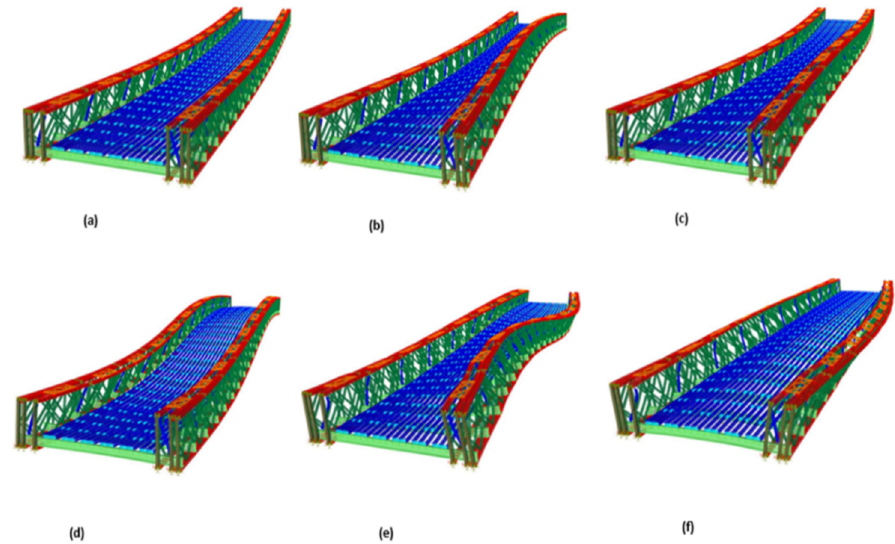
Figure 25. The first 6 eigenmodes of the FE model of the bridge ( a ) 1st: vertical bending at 2.87 Hz ( b ) 2nd: torsional-lateral at 3.22 Hz ( c ) 3rd: lateral-torsional at 4.38 Hz ( d ) 4th: second lateral at 7.50 Hz ( e ) 5th: second vertical bending at 8.73 Hz ( f ) 6th: non-identified at 9.87 Hz.